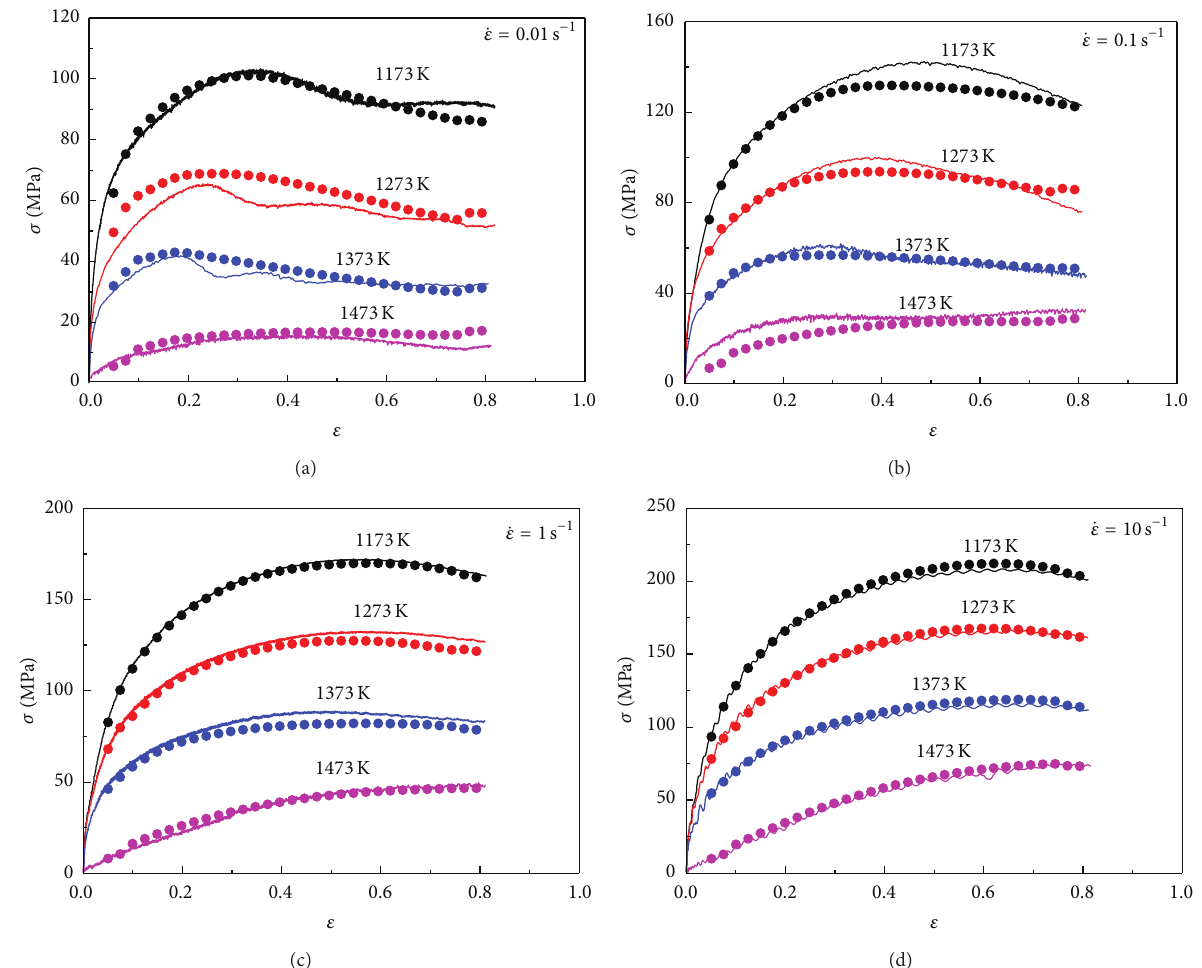
Figure 7: Comparison between the experimental and predicted flow stress by improved Arrhenius-type constitutive model at different strain rates and temperatures (a) 0.01 s −1 , (b) 0.1 s −1 , (c) 1 s −1 , and (d) 10 s −1 .